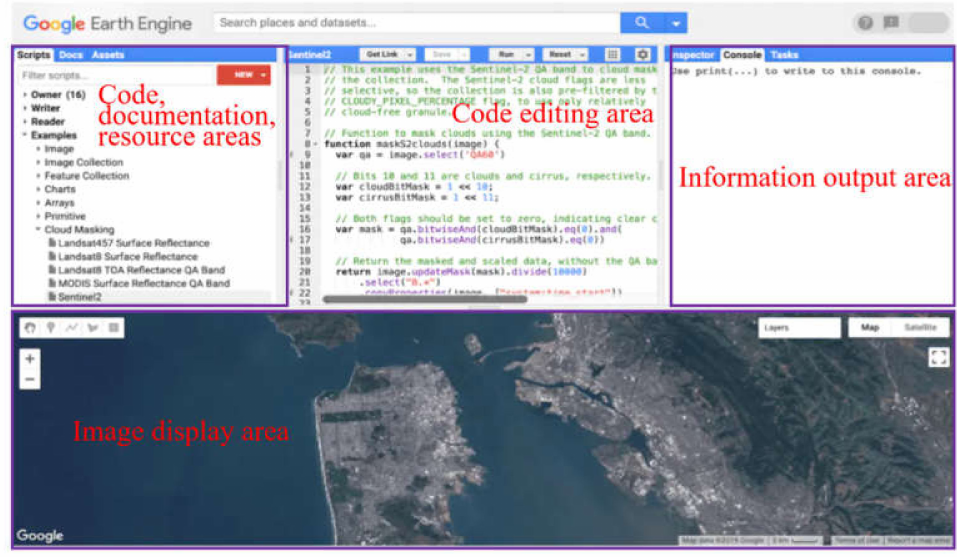
Figure 2. GEE cloud computing platform online code